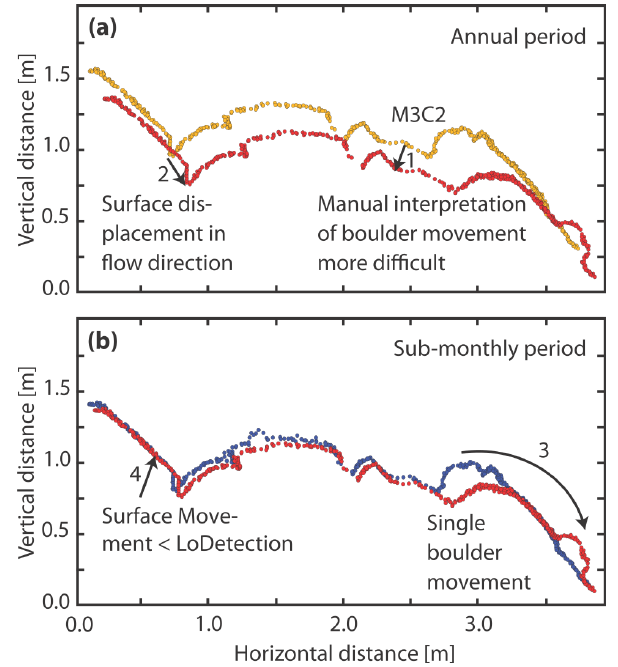
Figure 3. Schematic representation of different types of surface change that can be observed over a 1-year period (a) and a sub- monthly period (b) . While the M3C2 distance refers to surface change in a direction normal (i.e., perpendicular) to the surface (1), the measurements of surface displacement in the flow direc- tion reflect the creep-related movement of the rock glacier tongue (2). Additionally, individual boulder movement may occur (3). Over longer, annual periods, boulder movement is more difficult to iden- tify because of overlap with creep-related surface movement. In the sub-monthly period, individual boulder movement is easier to dis- tinguish, because creep-related changes are small and often below the level of detection (LoDetection)